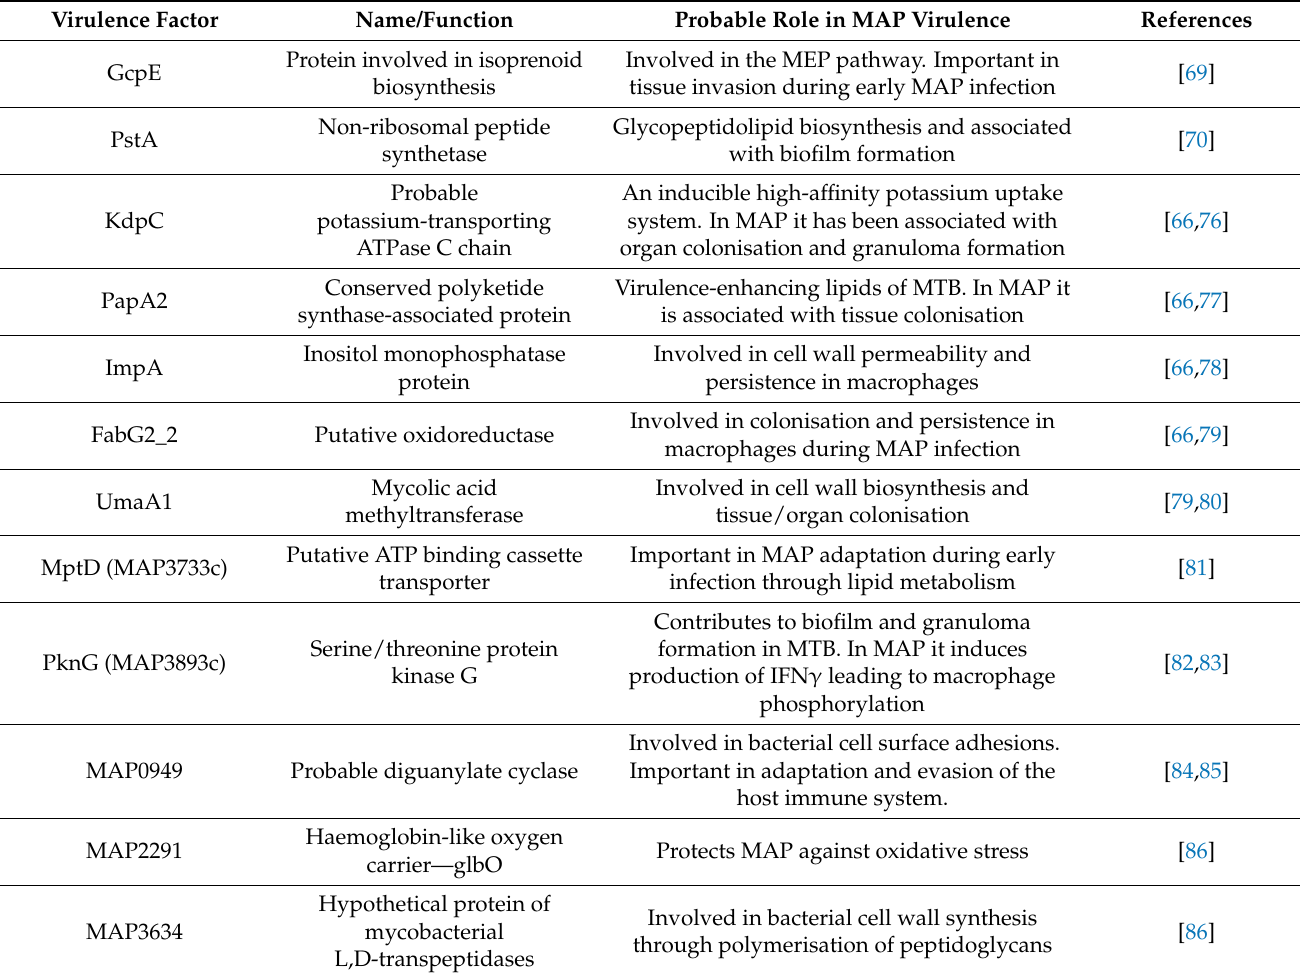
Table 1. Factors believed to influence virulence in MAP and other